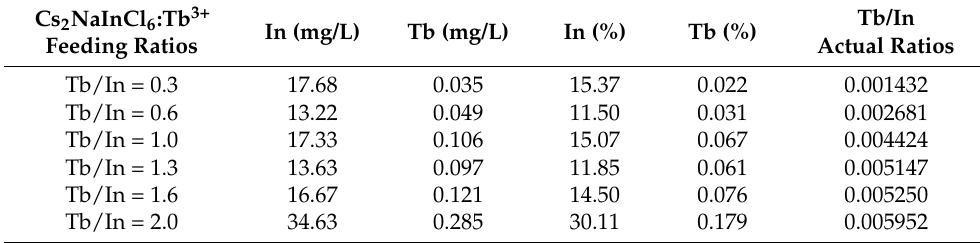
Table 1. The ICP-OES results of different feed ratios of Tb 3+ -doped Cs 2 NaInCl 6 DP